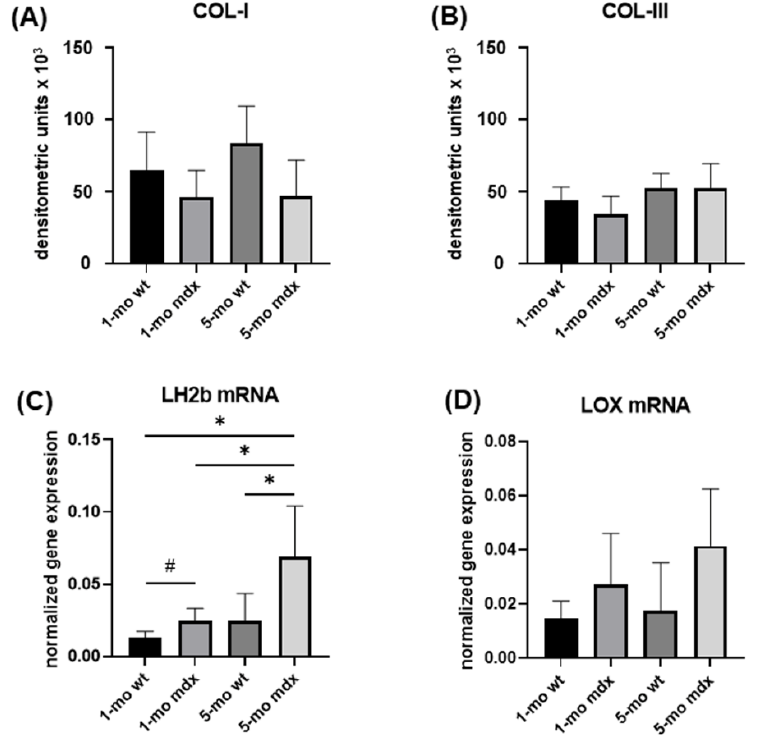
Figure 8. Representative bar graphs showing COL-I ( A ) and COL-III ( B ) levels in the cell culture supernatants of cultured QD muscle fibroblasts. Gene expression for LH2b ( C ) and LOX ( D ) were quantified by real-time PCR. Data are mean ± SD. * p < 0.05; # p < 0.05 for t -test.